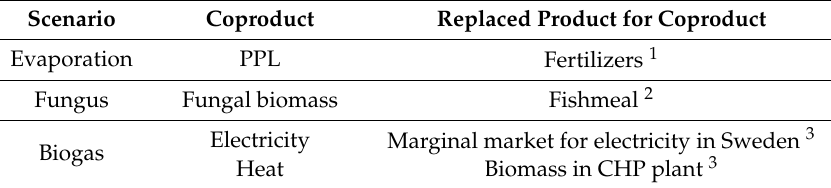
Table 4. Coproducts obtained from the three scenarios studied here and the alternative products that are replaced by the